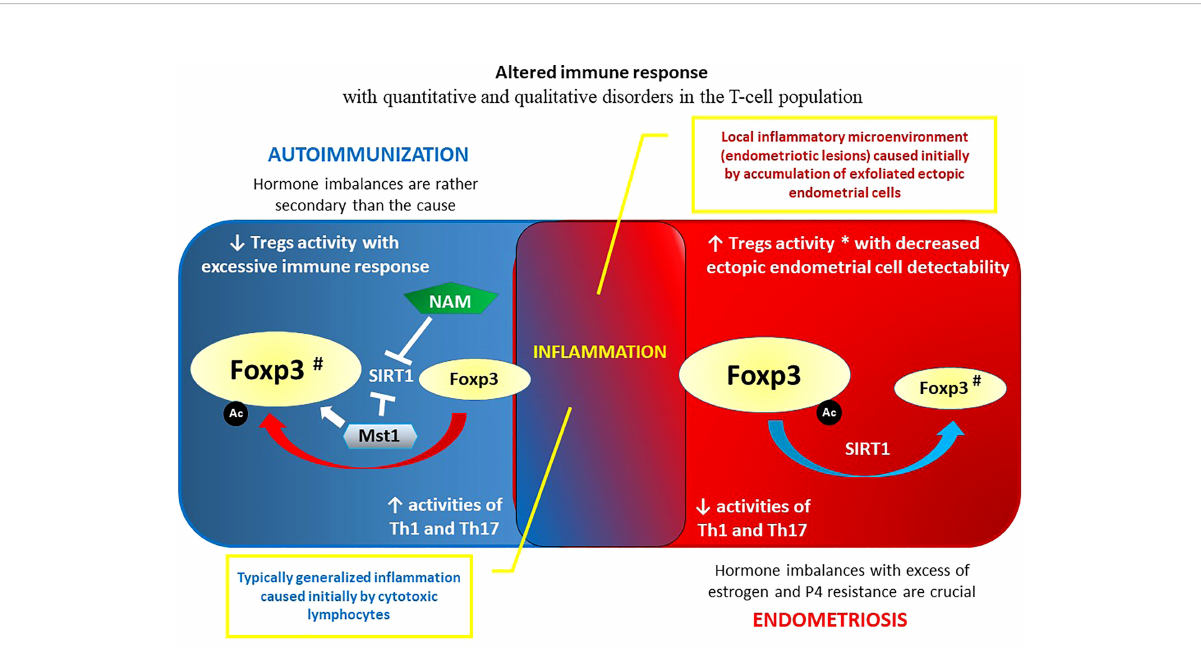
FIGURE 4 Regulatory T cells and altered immune response: autoimmune disease vs. endometriosis. Maintenance of Foxp3 protein expression in regulatory Tregs is crucial for a balanced immune response. The rationales for pharmacological modulation of SIRT1 activity in Tregs as an example of novel therapeutic approach for controlling immune responses in endometriosis and autoimmunity are also showed. # Restored to normal Foxp3 expression after the treatment; * It can also be opposite: increased number and activity of Tregs may be considered as an insuf fi cient compensatory mechanism to overcome in fl ammation (194, 195). Epigenetics of Tregs appears to be a common denominator for autoimmunity and endometriosis. See the main text (Chapter 3. The association between endometriosis and autoimmune diseases) for details. Ac – acetylation; Foxp3 – forkhead box P3 protein; Mst1 – mammalian sterile 20-like kinase 1; NAM – nicotinamide; SIRT1 – sirtuin 1 (silent mating type information regulation 2 homolog 1); Th1 – T helper 1 cells; Th17 – T helper 17 cells; Tregs – regulatory T